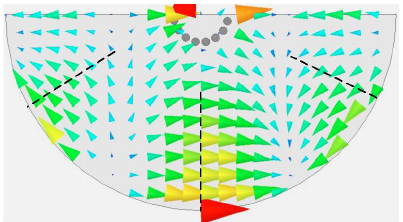
Figure 7. Current distribution of the TM310 mode.